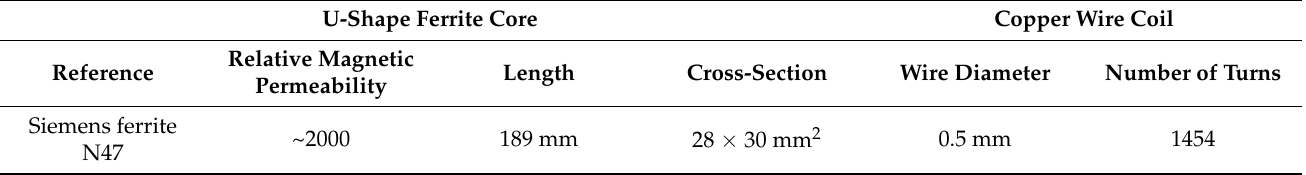
Table 1. Characteristics of the magnetic